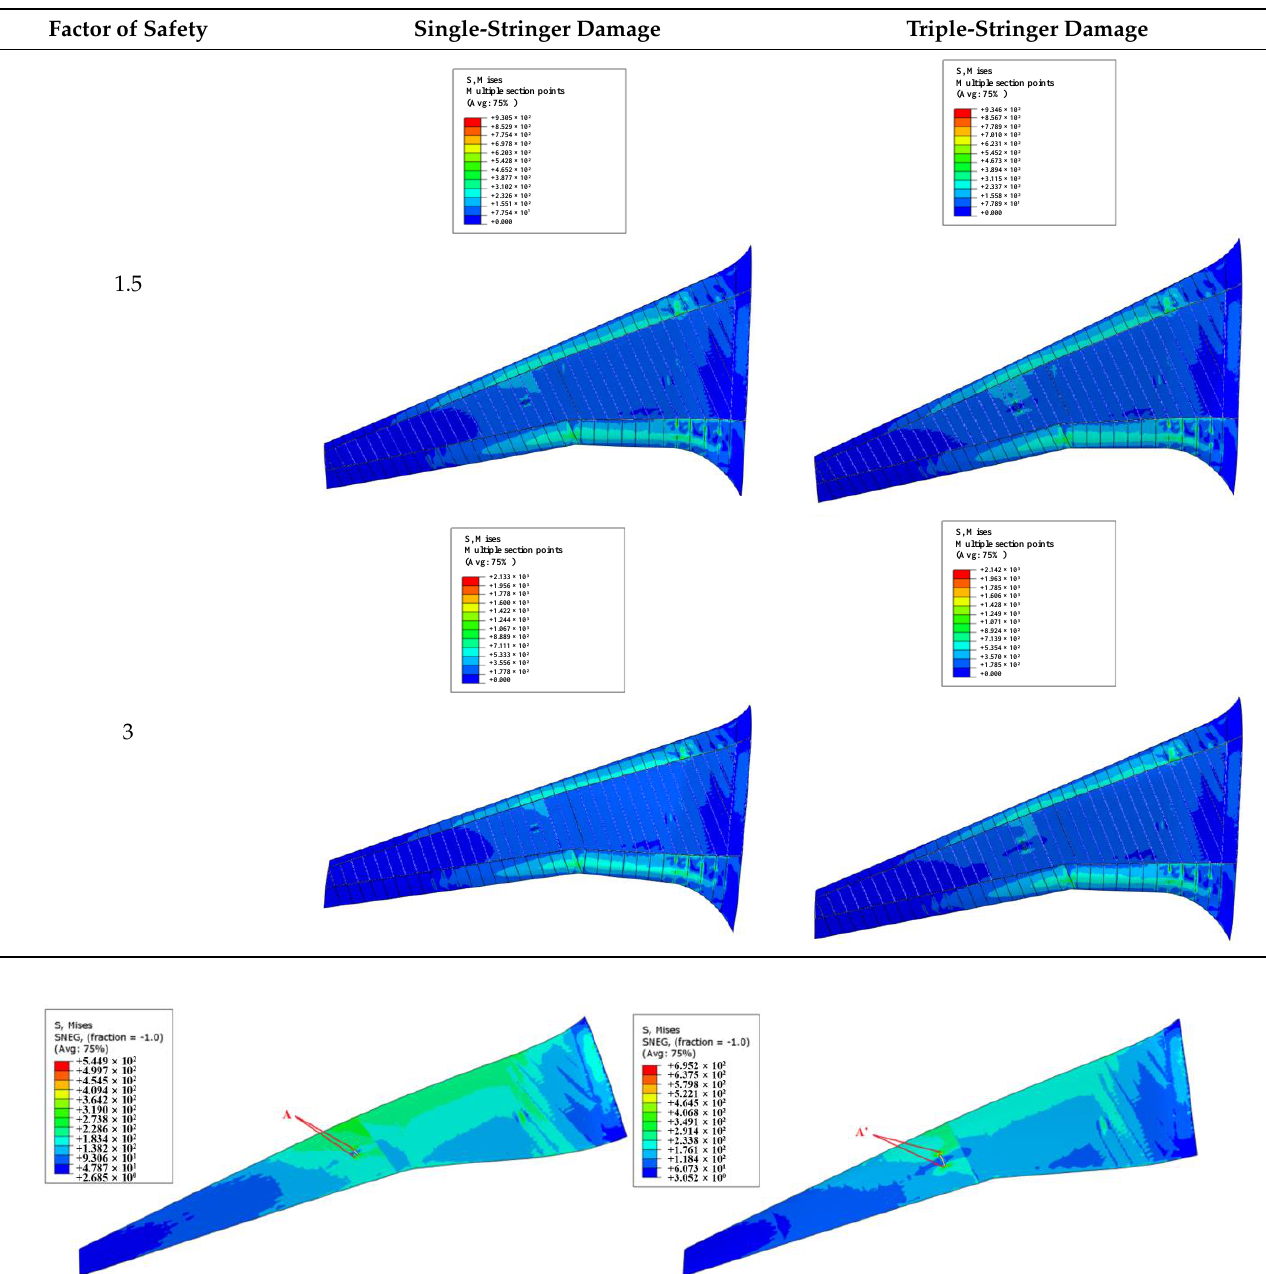
Table 6. Results of von Mises stress of single-stringer and triple-stringer damage BWB wings at different values of F.o.S.